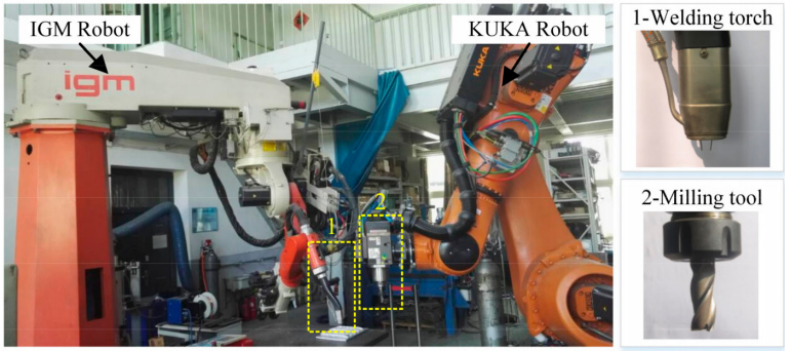
Figure 1. Two-robot cooperative hybrid manufacturing platform.